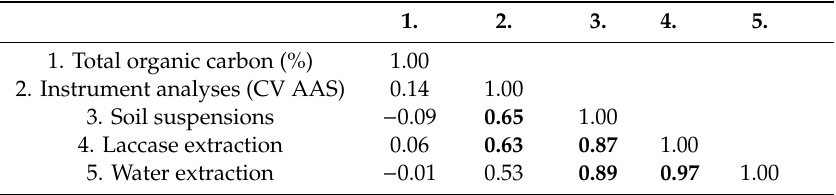
Table 2. Spearman correlation between soil Hg concentrations determined by instrument analyses (CV-AAS), bioluminescence response of the bioreporter and total organic carbon. Significant correlations ( α = 0.05 are typed